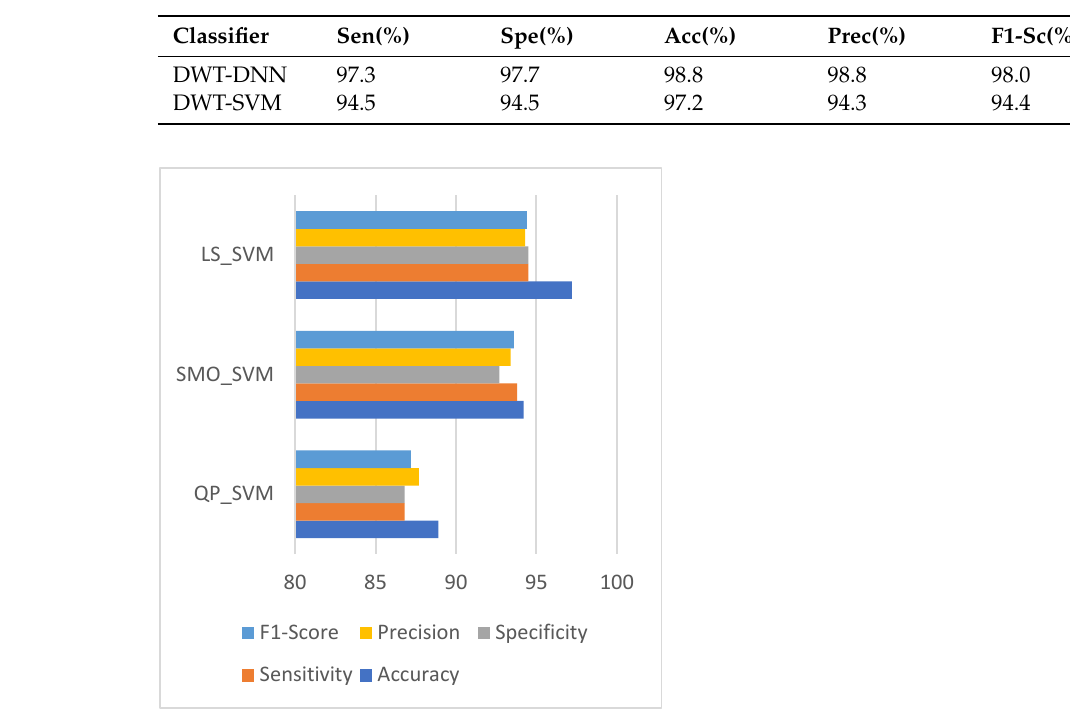
Table 4. Comparison between 1D-CNN and SVM for DWT features.